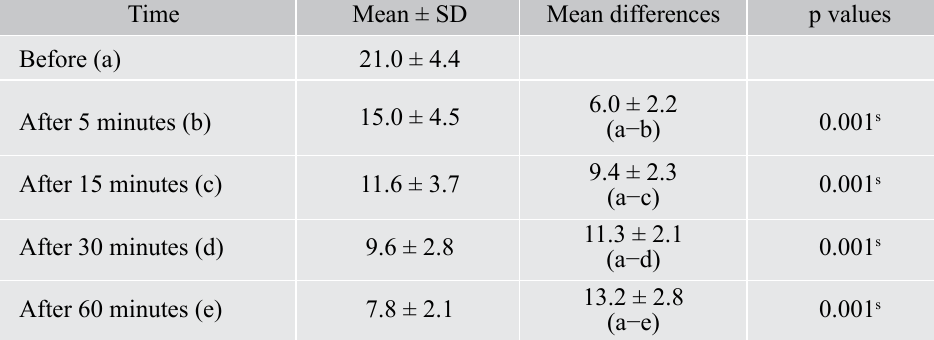
Table V: Comparison of net change of gallbladder volumes (in cm 3 ) between before and after smoking in Group I (n=15)